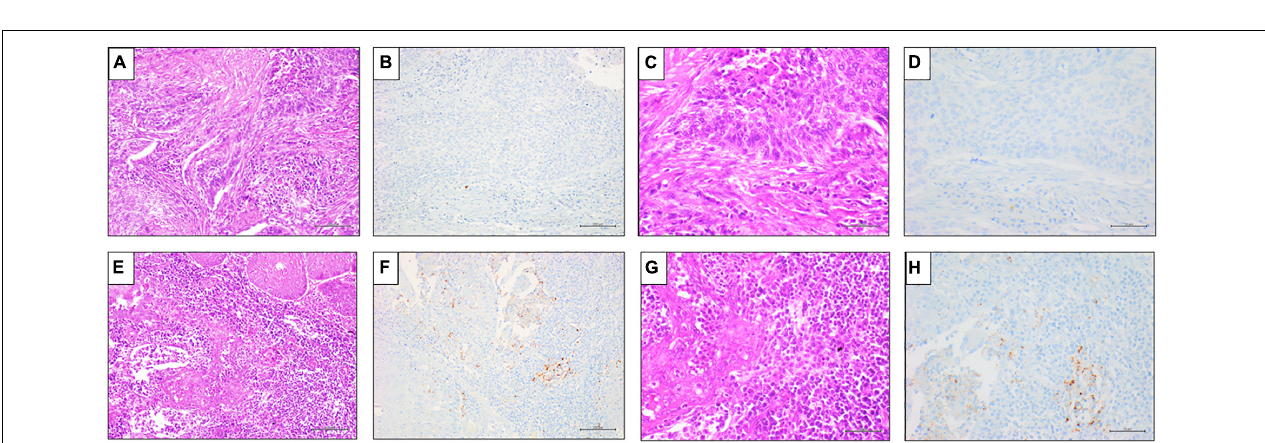
FIGURE 2 | Representative results of PD-L1 (clone SP263) IHC expression by CPS in penile SCC. (A,E,I) Hematoxylin and Eosin (H&E) staining (20x magnification, scale bar = 100 µ m); (C,G,M) Hematoxylin and Eosin (H&E) staining (40x magnification, scale bar = 200 µ m); (B,D) PD-L1 (clone SP263) IHC expression score ≤ 1%, DAB staining (40x magnification, scale bar = 200 µ m); (F,H) PD-L1 (clone SP263) IHC expression 1% < score < 20%, DAB staining (40x magnification, scale bar = 200 µ m); (L,N) PD-L1 (clone SP263) IHC expression ≥ 20%, DAB staining (40x magnification, scale bar = 200 µ m).